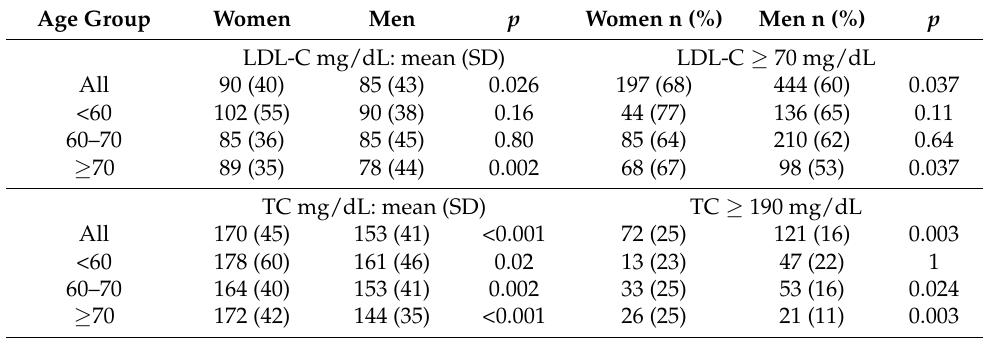
Table 3. Lipid profile according to gender and age at